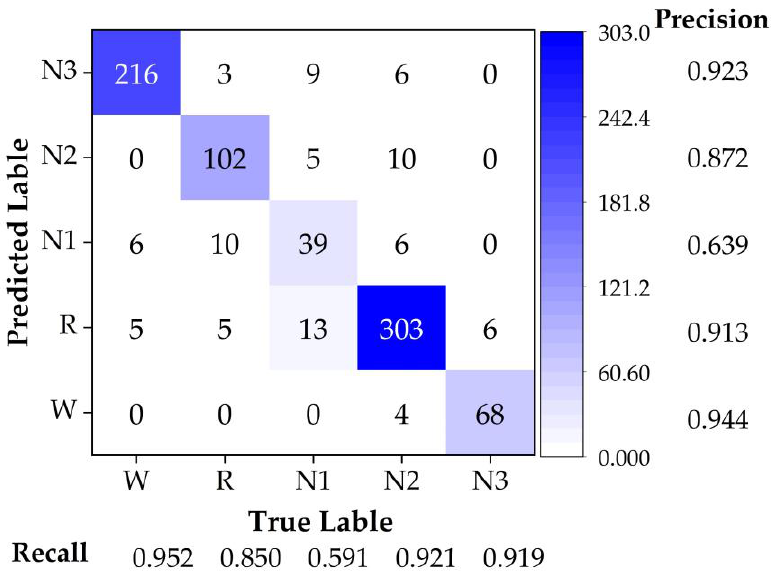
Figure 6. The confusion matrix of trained model was calculated with different stages for test set of SC4001.